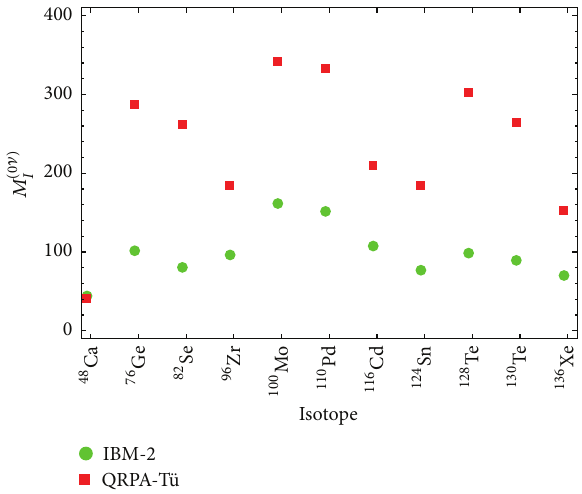
Figure 11: Most updated NMEs calculations for the 0 ] 𝛽𝛽 via heavy neutrino exchange with the IBM-2 [96] and QRPA-T¨u [174] models. for the axial coupling constant In both cases, the value 𝑔 𝐴 = 𝑔 nucleon and the Argonne parametrization for the short-range correlations are assumed. The results show a continuous overestimation of the QRPA estimations over the IBM-2